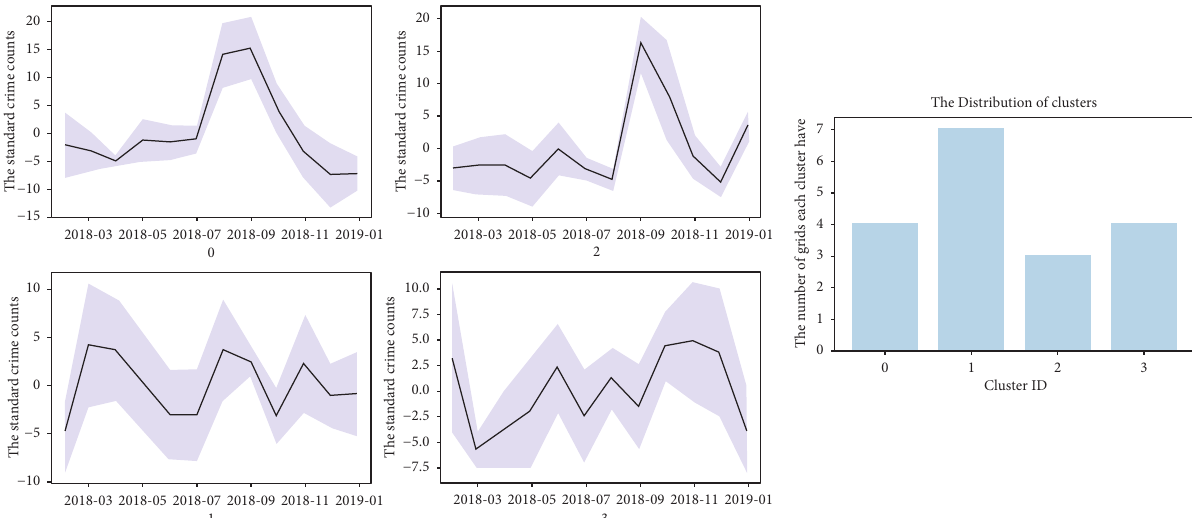
Figure 14: The theft in Santa Monica trends in each month in 2018 and the distribution of clusters. The line charts are the monthly trends of theft in Santa Monica in 2018. The bar chart is the distribution of the